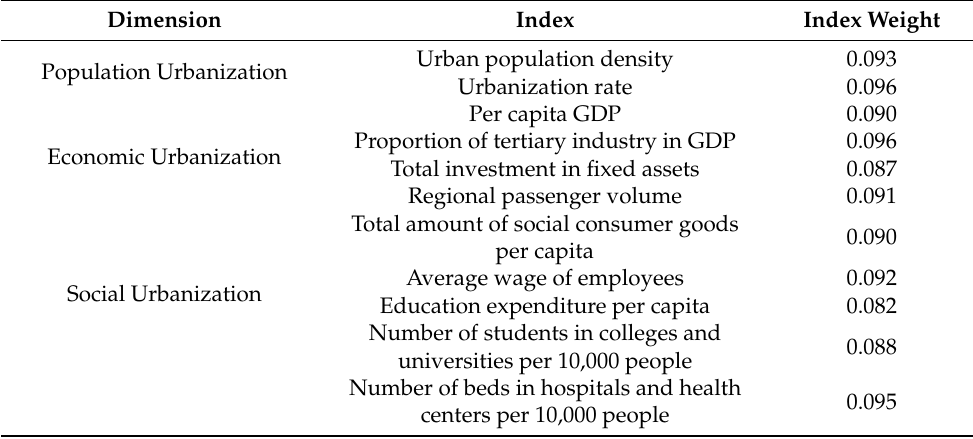
Table 1. Comprehensive measurement index system for the level of urbanization.